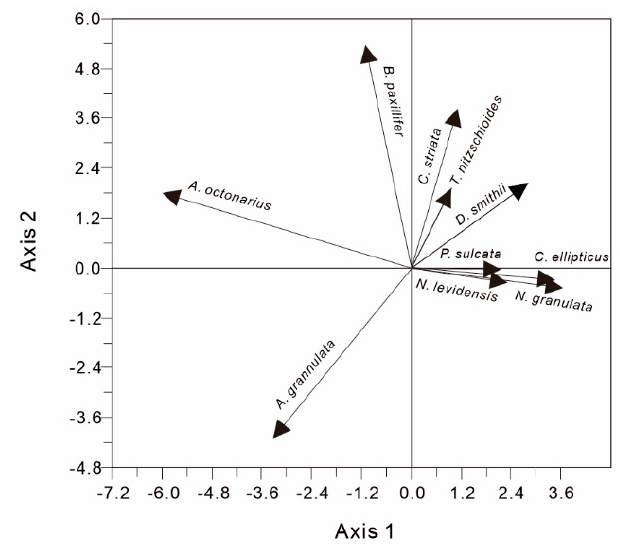
Figure 3. Principal component analysis (PCA) taxa scatter diagram of axis 1 against axis 2.